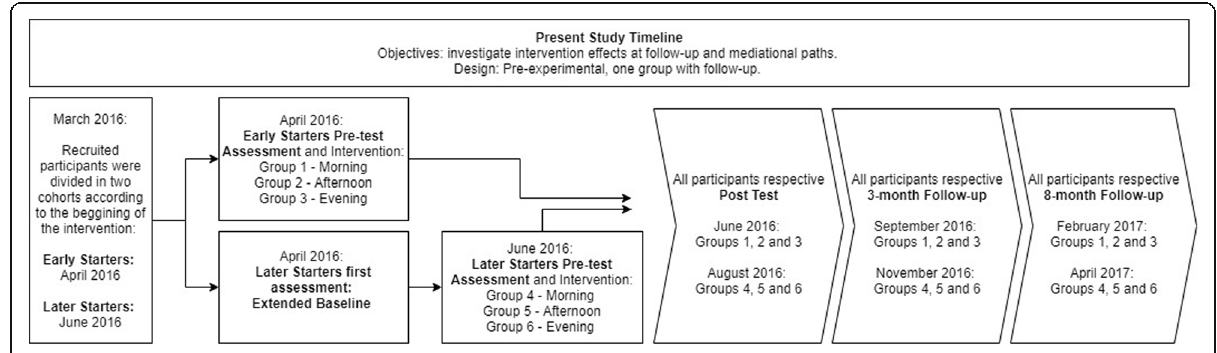
Fig. 1 Present study timeline and procedures. Each rectangle represents procedures in the study ’ s